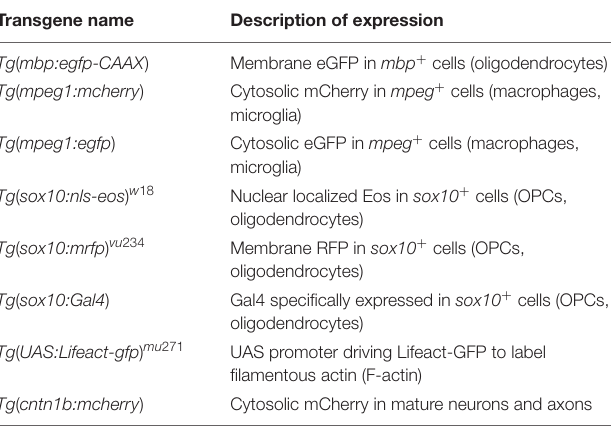
TABLE 1 | Descriptions and abbreviations of transgenic lines used in this